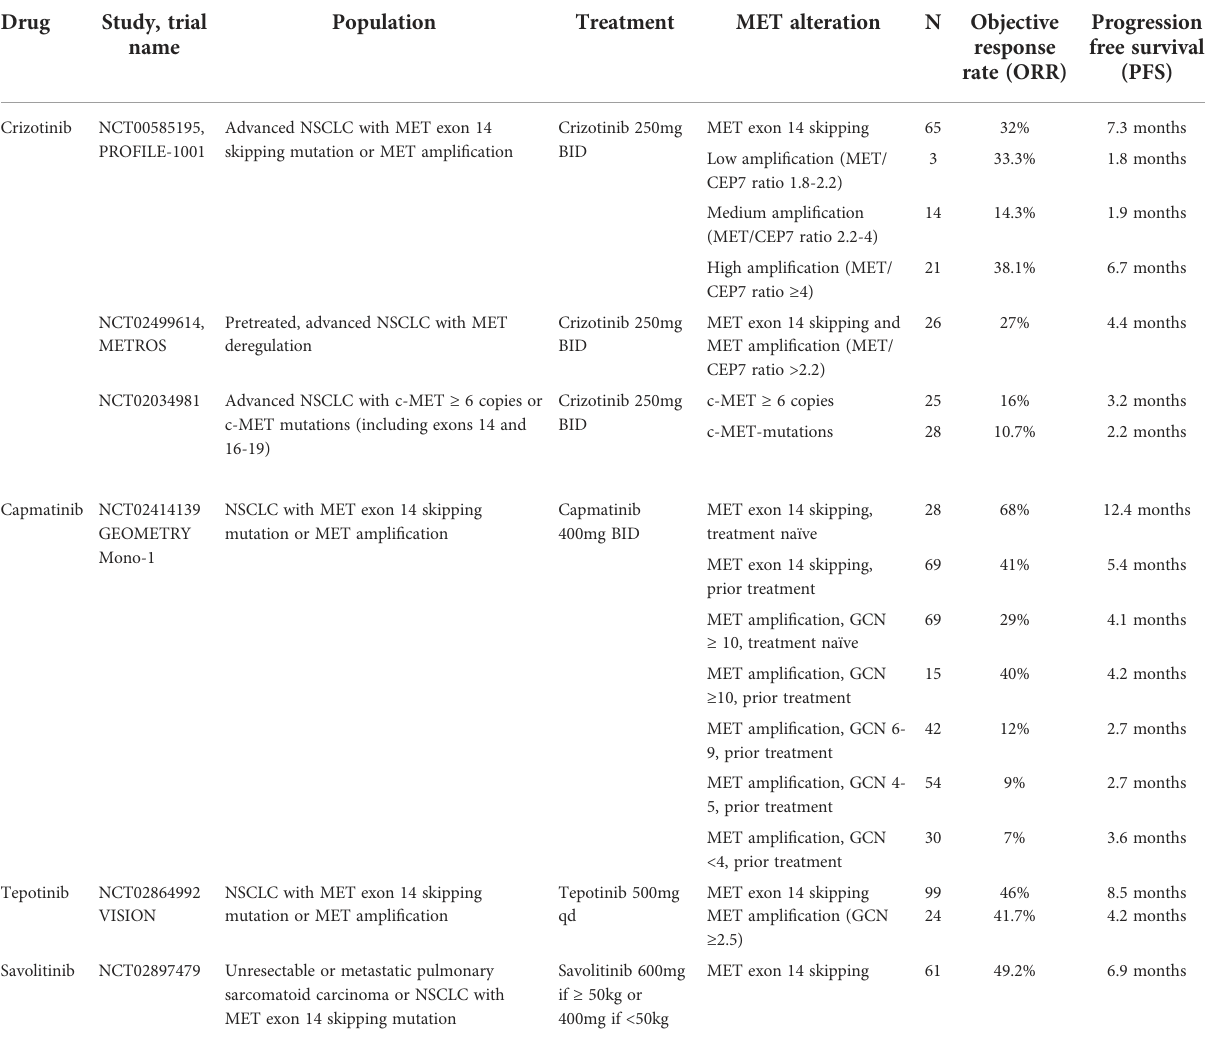
TABLE 1 Published Trials of Type I MET TKIs.